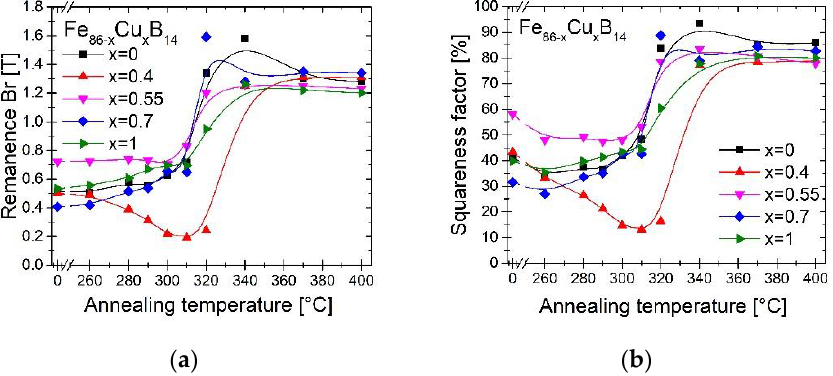
Figure 5. Remanence Br ( a ) and squareness factor Sf ( b ) dependence on annealing temperature Ta.